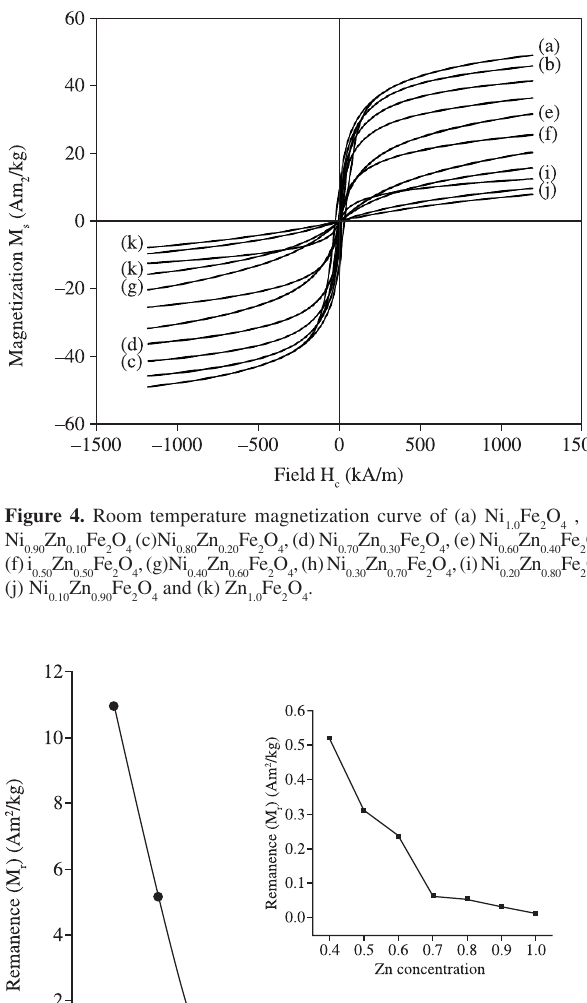
Figure 5. Variation of specific saturation magnetization with Zn concentration for Ni Zn Fe O with x varying from 0 to 1-x x 2 4